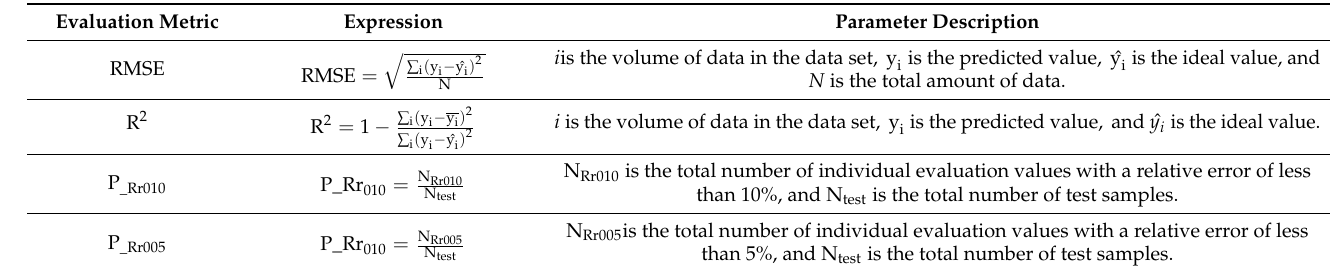
Table 2. Performance evaluation metrics and its